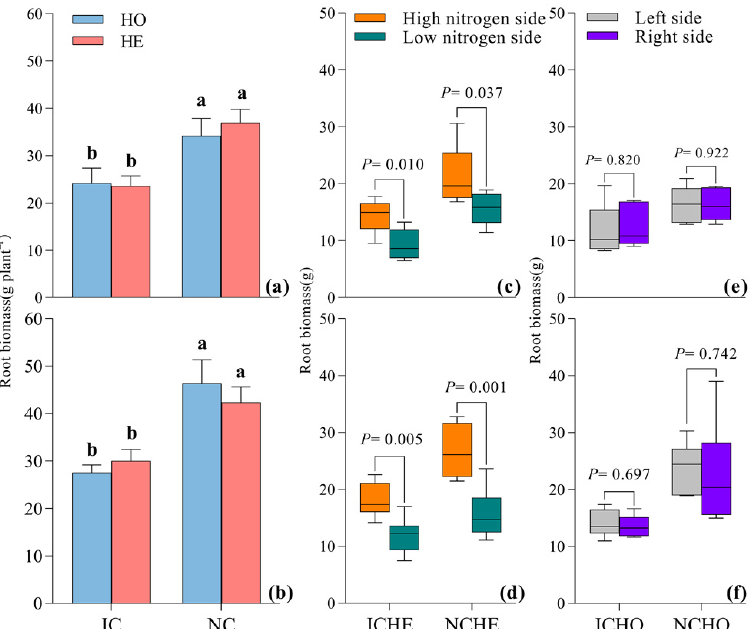
Figure 7. Effect of nitrogen distribution pattern and intraspecific competition on root biomass. ( a ) Total root biomass at flowering stage. ( b ) Total root biomass at mature stage. ( c ) Root biomass with heterogeneous distribution of nitrogen at flowering stage. ( d ) Root biomass with heterogeneous distribution of nitrogen at mature stage. ( e ) Root biomass with homogeneous distribution of nitrogen at flowering stage. ( f ) Root biomass with homogeneous distribution of nitrogen at mature stage.